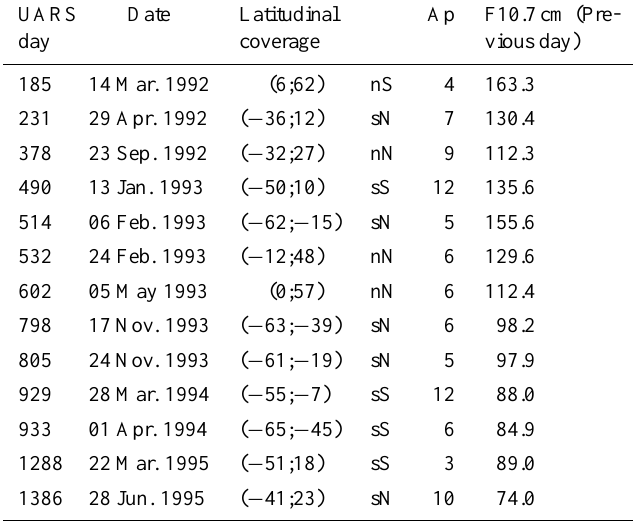
Table 1. List of days used to compare the temperatures of the two FOVs. The latitudinal coverage is the part that is common to both FOVs. The two added letters indicate if WINDII was looking north- ward or southward of the orbital plane (n or s) and if the satellite was travelling northward or southward in its orbit (N or